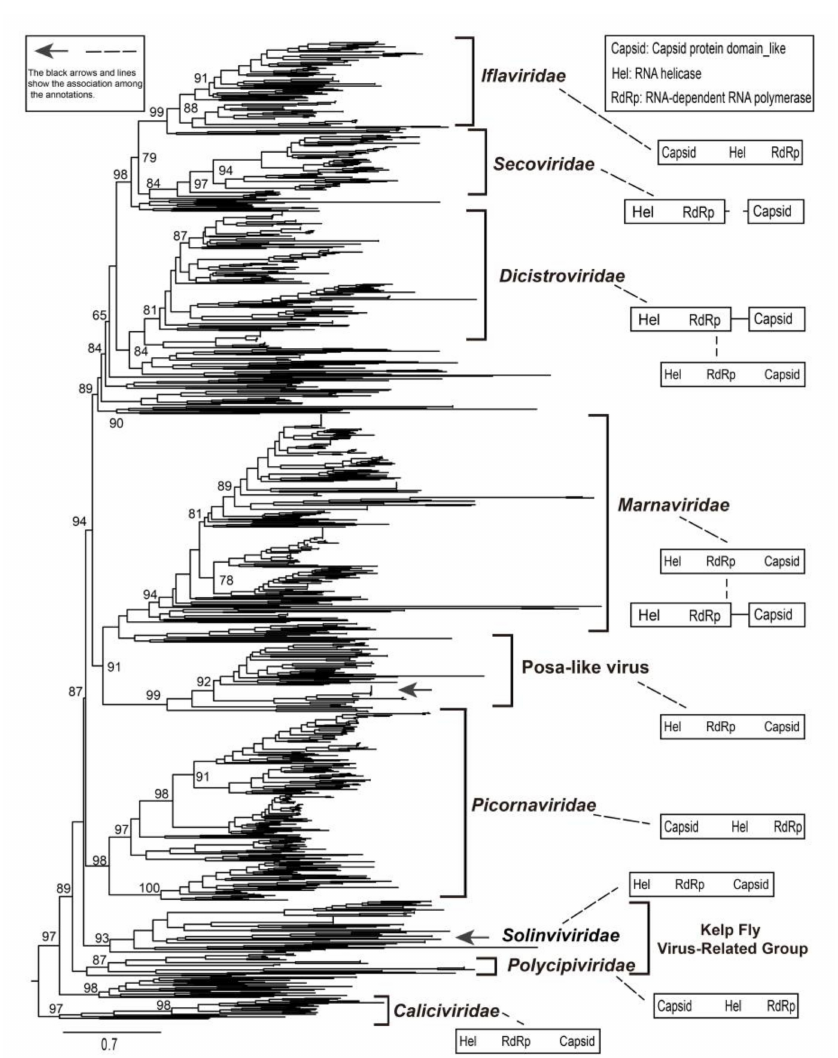
Figure 4. The maximum-likelihood phylogenetic tree of posa-like viruses, other known families, and unclassified viruses of Picornavirales . The conserved amino acid sequences of RdRp were used to generate phylogenetic trees. Scale bars indicate the substitutions per site per year. The numbers at each nodeindicatetheSH-likeapproximatelikelihoodratiotest(SH-aLRT)supportvalue, with1000iterations. The black arrows represent the husavirus strains identified in the present study. The genomic organization on the right shows the major non-structural and structural domains, with the arrangement of open reading frames (ORFs) based on previous reports